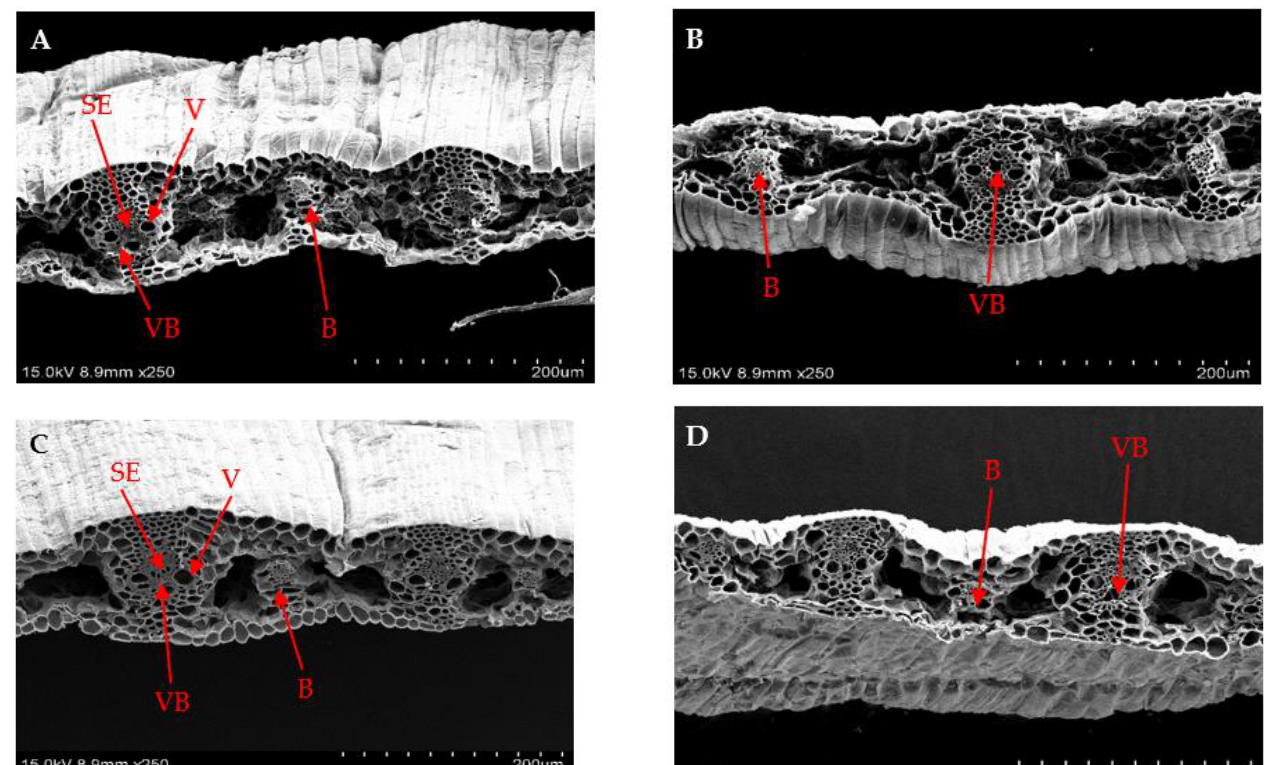
Figure 7. Leaf lateral vein crosscutting structures of Kentucky bluegrass ramets in different